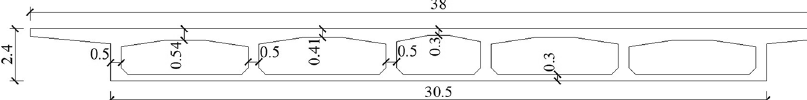
Fig. 19 The section size (unit: